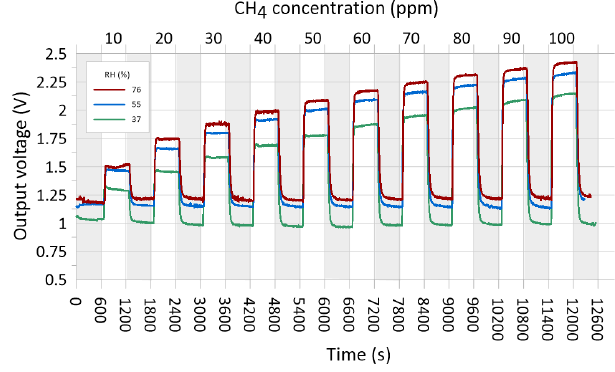
Figure 4. Outlet voltages of the MOS during laboratory step cali- bration at stabilized levels of relative humidity (37 ± 2%, 55 ± 3%, and 76 ± 3%) in both the zero and span gas at alternating concen- tration of CH 4 in the calibration gas between 10 and 100ppm CH 4 . Each time step lasted 10min, and sequences with grey shading show time periods where the sensor was exposed to CH 4 -free zero gas.